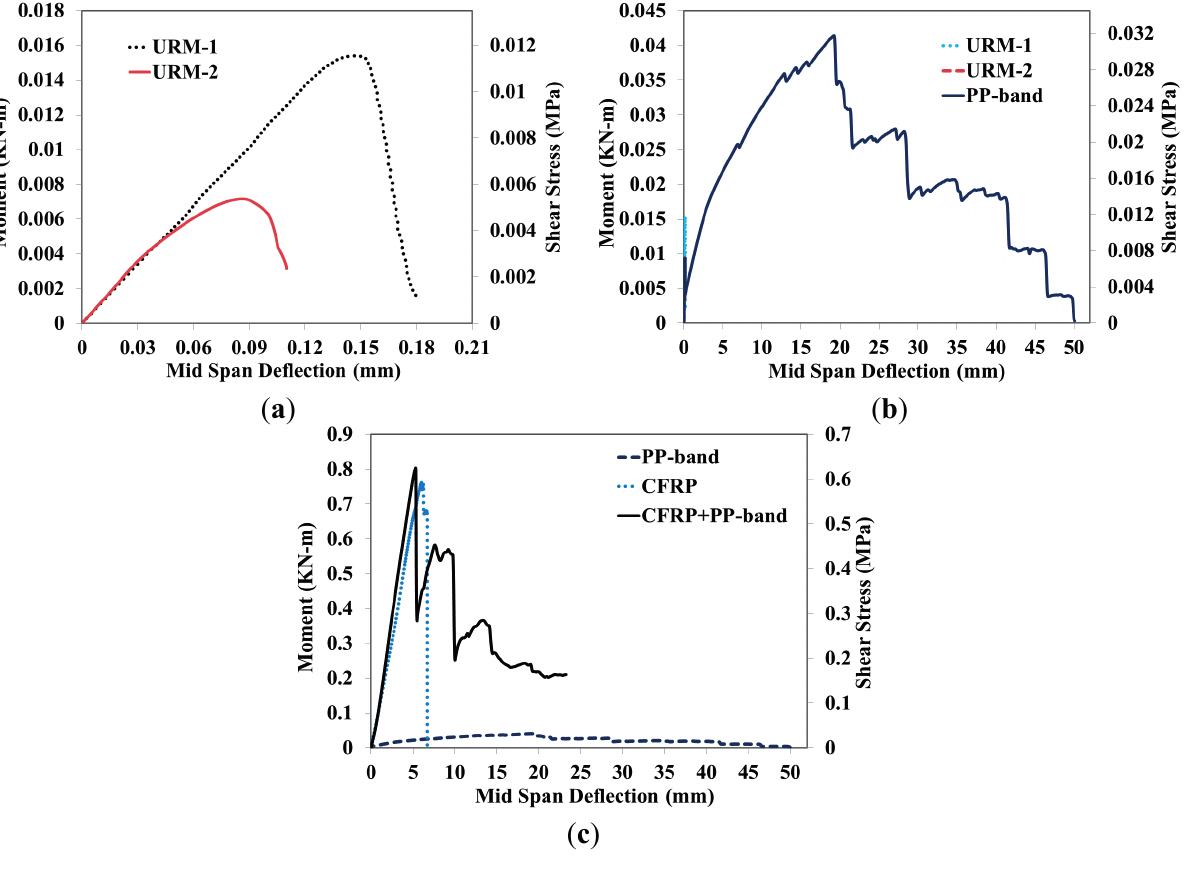
Figure 7. Moment-deflection curves of Type-2 masonry panels under out-of-plane load for ( a ) URM, ( b ) URM and PP-band retrofitted and ( c ) PP-band, CFRP and CFRP + PP-band